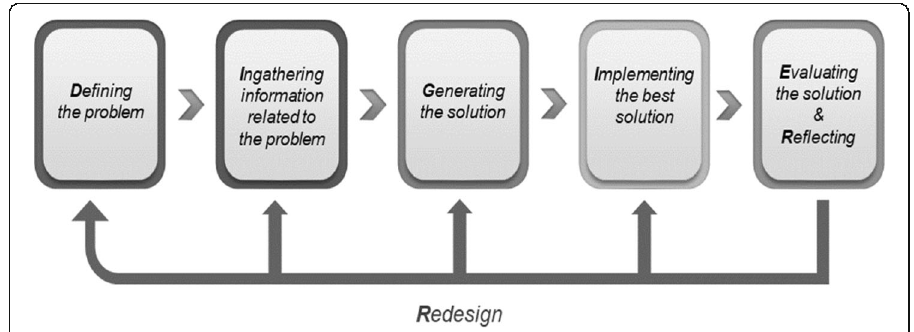
Fig. 2 Stages of the DIGIER 2